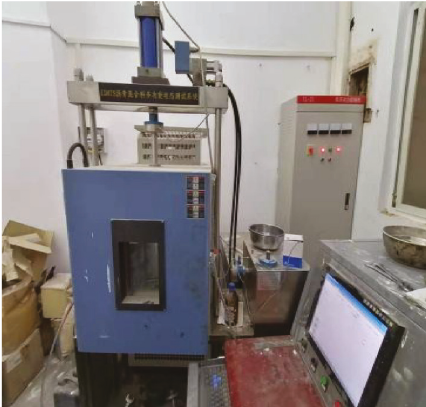
Figure 5: Multi-function dynamic testing system for asphalt mixture.